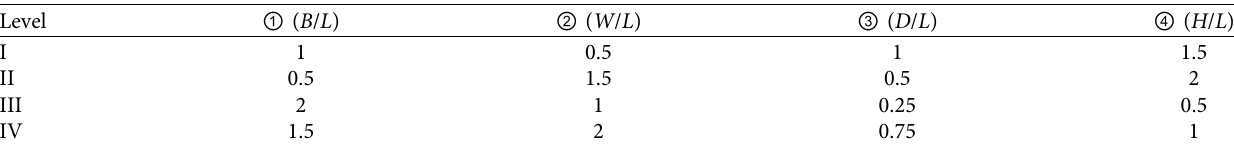
Figure 5: Changes of experiment deviation in different levels in four single factor tests. (a) Experiment deviation with B / L changing from 0.5 to 3. (b) Experiment deviation with W / L changing from 0.5 to 3. (c) Experiment deviation with D / L changing from 0 to 1. (d) Experiment deviation with H / L changing from 0.5 to 3. Table 4: Level of the factors in the orthogonal